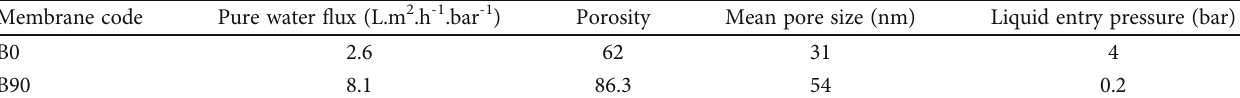
Table 3: The e ff ect of the bore liquid composition on the pure water fl ux, porosity, mean pore size, and liquid entry pressure. Membrane code Pure water fl ux (L.m 2 .h -1 .bar -1